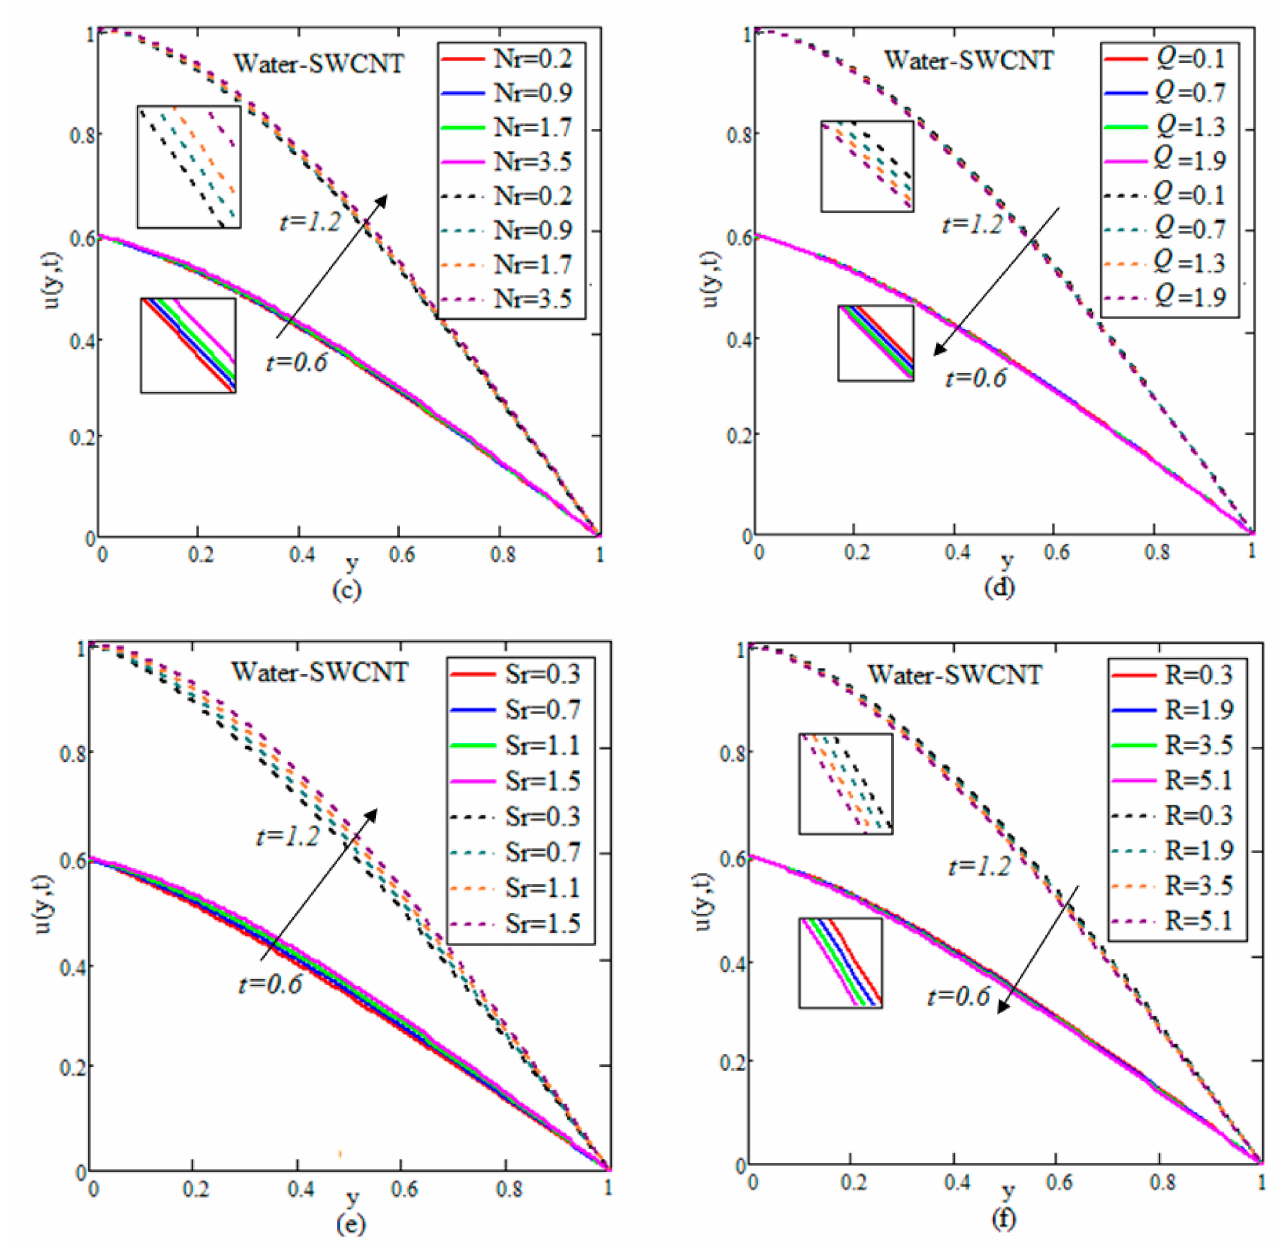
Figure 4. ( a – f ) Deviation of